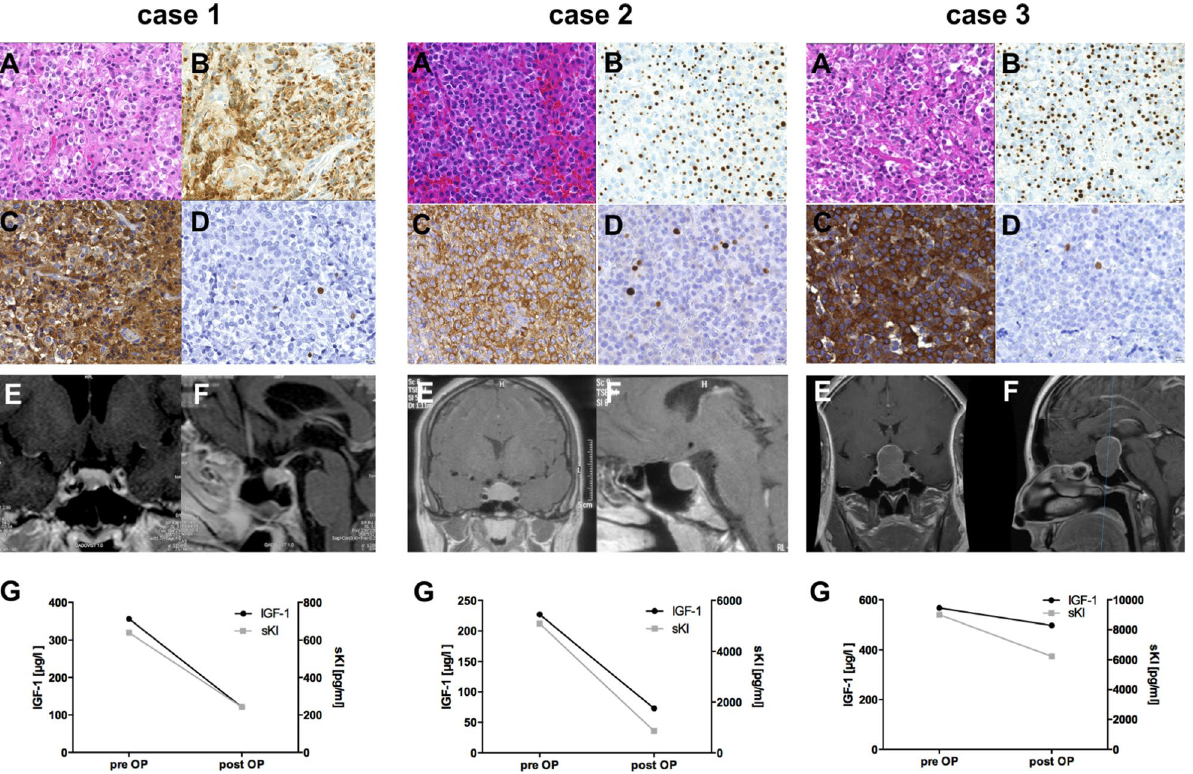
Figure 3. Exemplary cases of patients belonging to different pituitary adenoma subgroups suggested by Cuevas-Ramos et al. Case 1 belongs to Cuevas-Ramos type 1, case 2 to the type 2 group, and case 3 to type 3. Panels ( A ) show H&E staining, ( B ) CK staining ( C ) GH staining, ( D ) MIB-1 staining. Preoperative MR images with gadolinium contrast are depicted in coronal ( E ) and sagittal ( F ) sections. Preoperative and